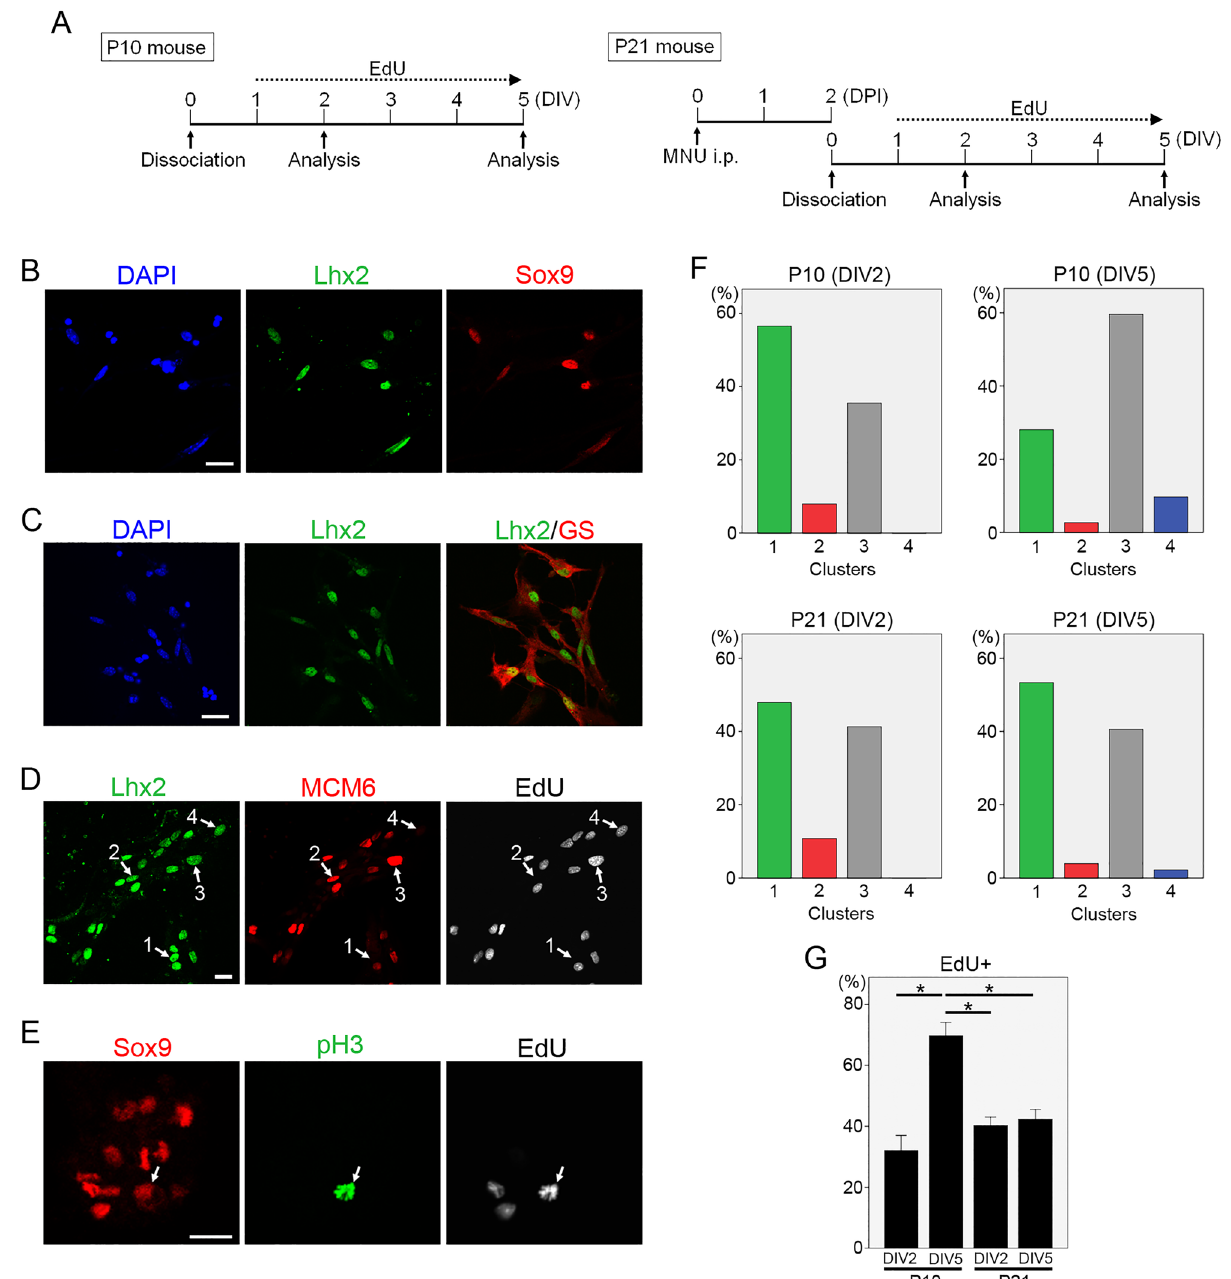
Figure 3. Dissociated cultures of mouse Müller glia. ( A ) Diagrams showing experimental design. P10 and P21 mouse retinas were dissociated and cultured in the continuous presence of EdU. P21 retinas were dissociated 2 days after MNU treatment. Cell were fixed and analyzed by immunofluorescence at 2 days in vitro (DIV2) and DIV5. DPI, days post-injection. ( B ) Colocalization of Müller glia markers Lhx2 and Sox9. Scale bar = 20 µm. ( C ) Colocalization of Müller glia markers Lhx2 and glutamine synthetase (GS). Scale bar = 20 µm. ( D ) Lhx2 + Müller glia were classified into four clusters based on MCM6 and EdU labeling (arrows with numbers). Scale bar = 20 µm. ( E ) Phospho-histone H3 (pH3) + Müller glia in M phase (arrows). Scale bar = 20 µm. ( F ) Histograms showing the proportions of each cluster. Totally 3796 cells (DIV2) and 5554 cells (DIV5) from P10 retinas and 5250 cells (DIV2) and 3864 cells (DIV5) from P21 retinas were analyzed. ( G ) Proportions of EdU + Müller glia. Each bar represents the mean ± SEM, P * <